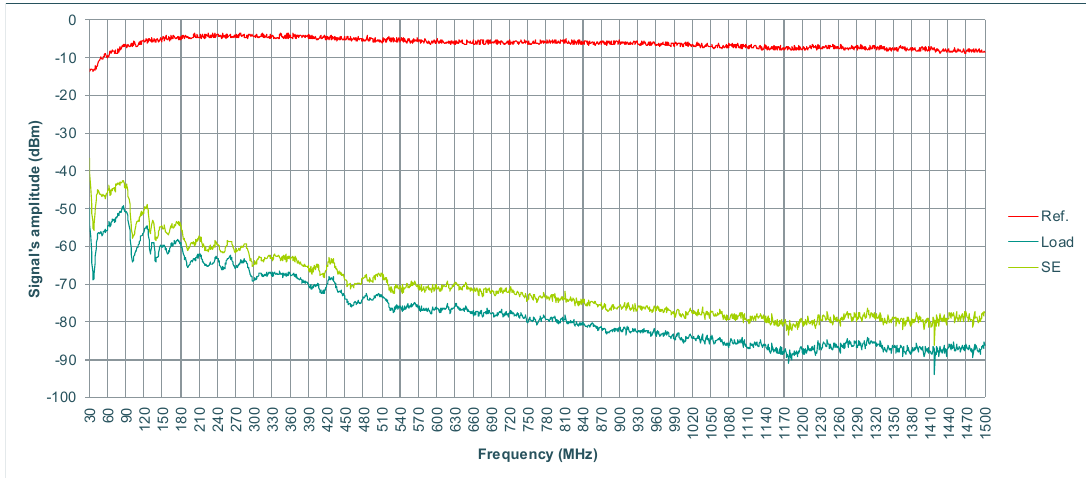
Figure 8. Signal’s amplitude vs. frequency for the CF/Rosin bio-composite.